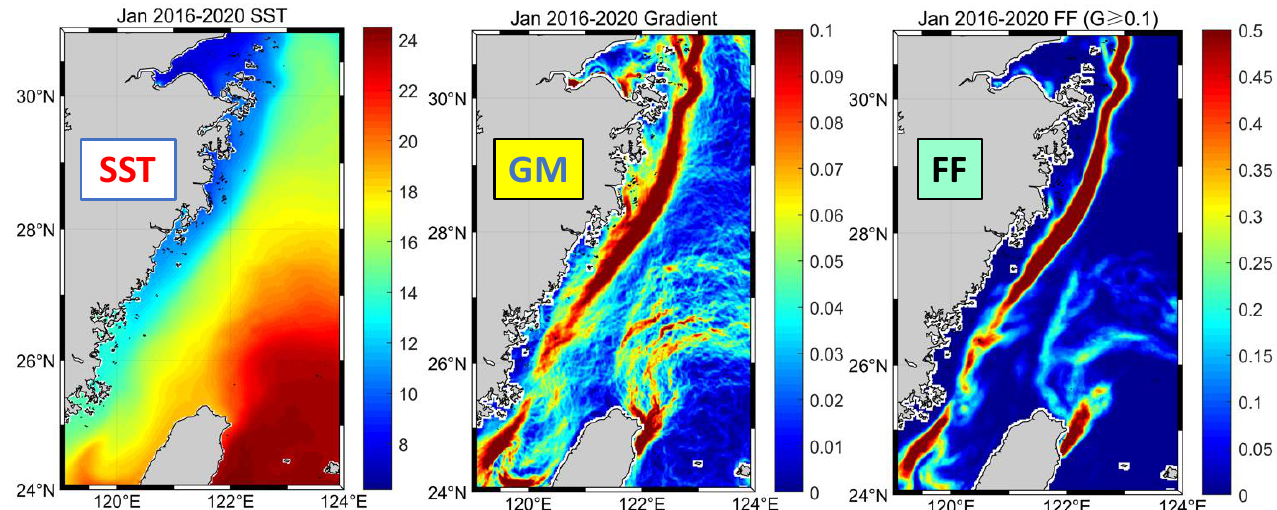
Figure 3. Long-term (2016 – 2020) mean January maps. Left, SST (°C); center, SST gradient magnitude GM (°C/km); right, Frontal frequency FF at GM ≥ 0.1 °C/km. In order to show fine (submesoscale) fronts, the GM color scale is cut off at 0.1 °C/km; peak values of GM at some grid points could be much higher (up to 0.4 °C/km).